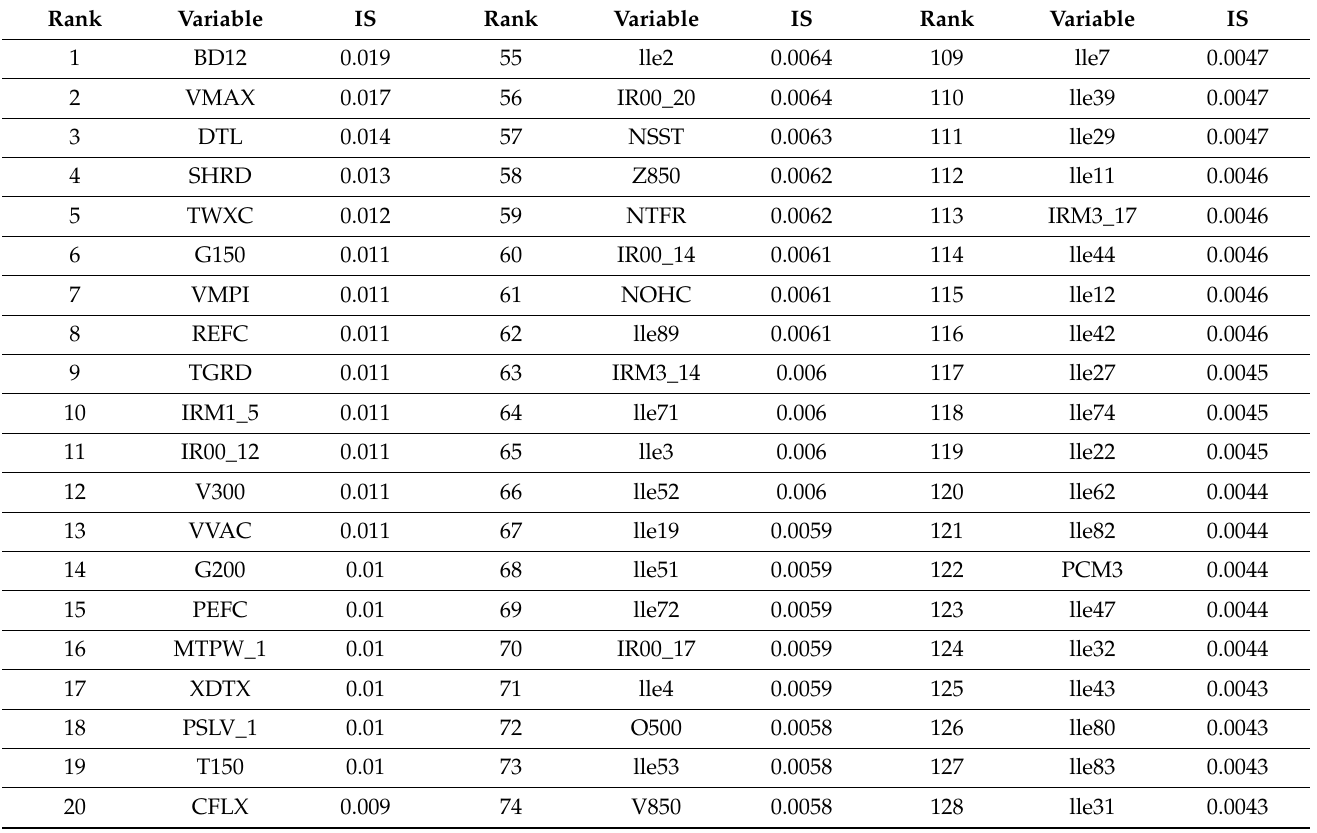
Table A1. LLE-SHIPS model feature importance score (IS) and its